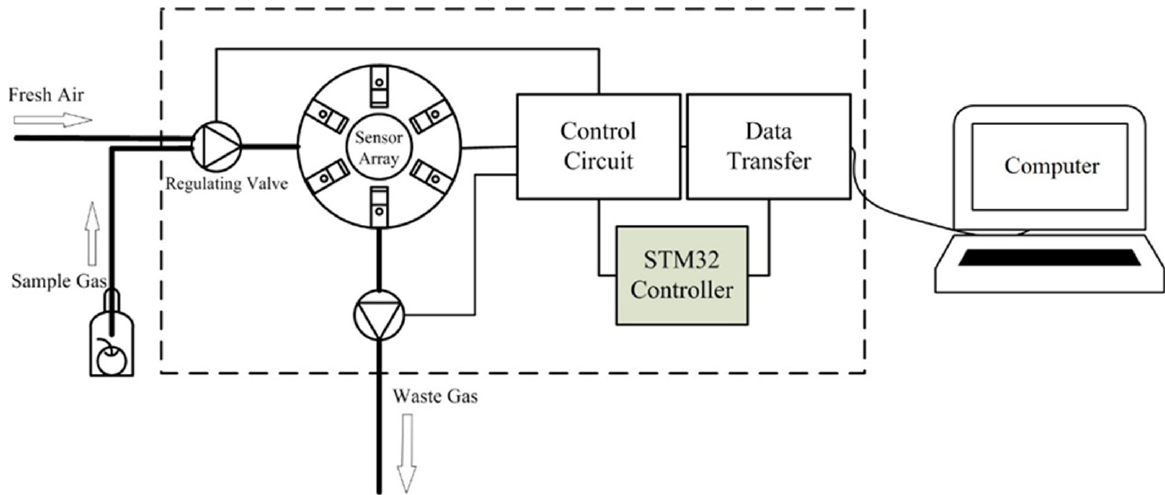
Figure 1. The schematic illustration of the developed electronic nose system.